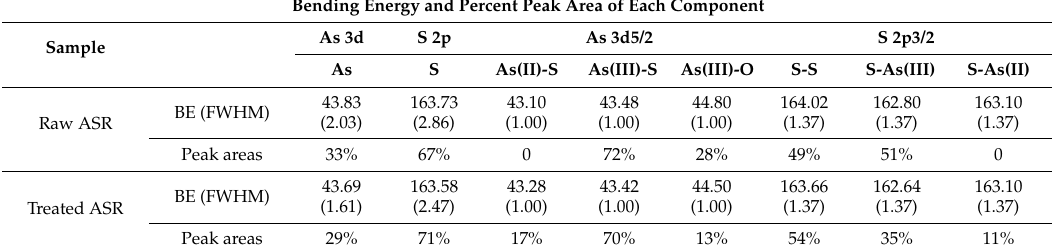
Table 8. Peak areas for component peaks used in fitting the As (3d) and S (2p) peaks for the raw HB-ASR and treated ASRs.